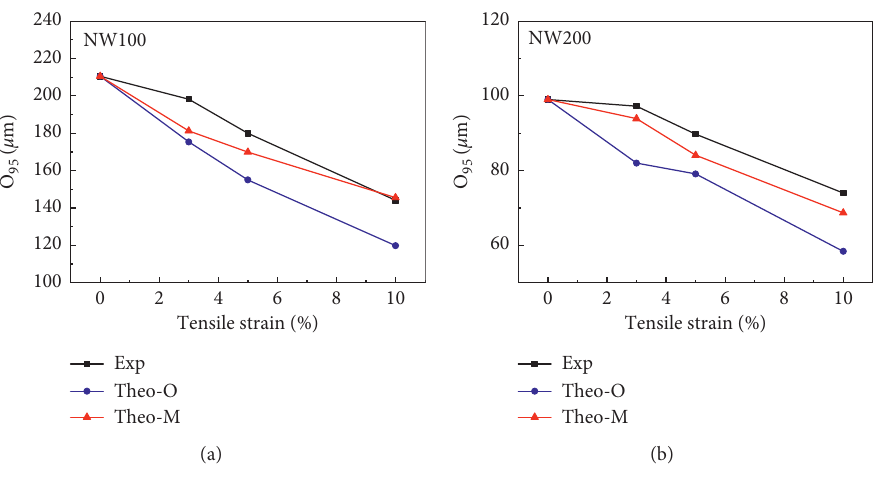
Figure 8: Experimental and theoretical O 95 tested by dry sieving test. (a) NW100. (b) NW200. Table 3: Properties of nonwoven structures